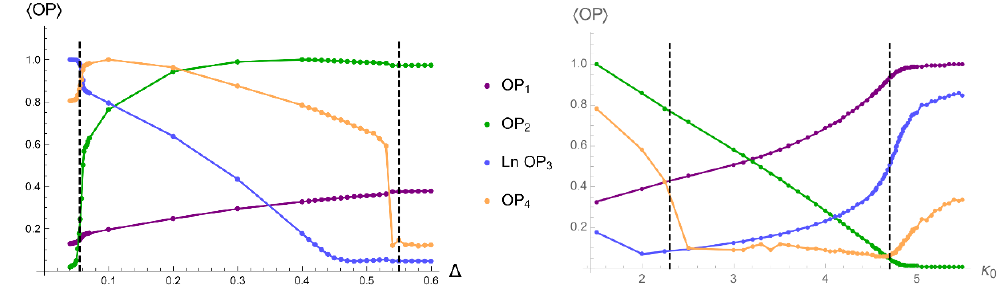
Figure 12 . Behaviour of the order parameters OP 1 , . . . , OP 4 , de(cid:12)ned in eqs. (4.1){(4.4), in CDT with toroidal spatial topology ((cid:6) = T 3 ) and (cid:22) N = 160000, t tot = 4. The left plot shows the mean (4 ; 1) OPs as a function of (cid:1) for (cid:12)xed (cid:20) 0 = 1 : 5, which corresponds to a vertical line in the phase diagram in (cid:12)gure 10, and the right plot shows the mean OPs as a function of (cid:20) 0 for (cid:12)xed (cid:1) = 0 : 4, which corresponds to a horizontal line in the phase diagram in (cid:12)gure 10. The OP 1 , OP 2 and OP 4 were rescaled to (cid:12)t into a single plot, and due to a very large range of OP 3 (a few orders of magnitude) we plot the rescaled ln OP 3 instead of OP 3 , the rescaling in the left plot being identical to that in the right plot. The qualitative behaviour of the OPs is the same as for phases A , B , C dS and C b in CDT with spherical spatial topology (see (cid:12)gure 5 and table 1). The positions of the B (cid:0) C b and C b (cid:0) C phase transitions on the left plot and the C b (cid:0) C and C (cid:0) A phase transition on the right plot are marked by dashed